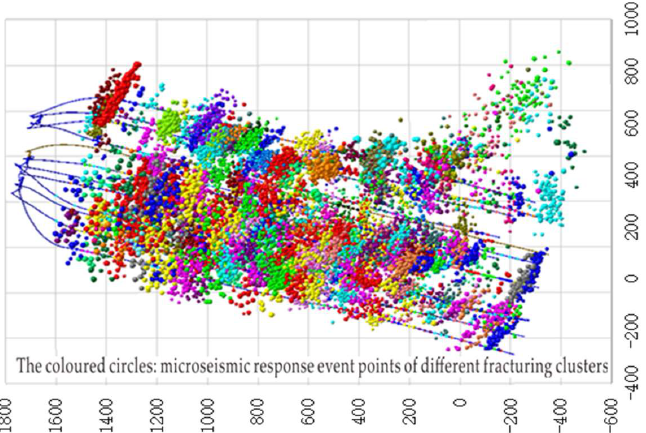
Figure 1 . Microseismic interpretation of the M131 demonstration project.